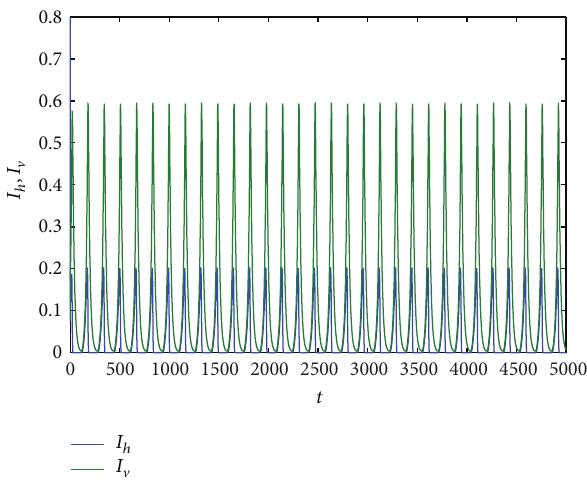
Figure 7: Trajectory picture with time 𝑡 when 𝑟 = 0.8 , 𝐾 = 10 , = 1 , 𝑎 = 1 , 𝑎 = 0.3 , 𝑑 𝛽 1 1 2 = 0.06 , 𝛽 = 0.26 , and 𝑁 𝑑 V 2